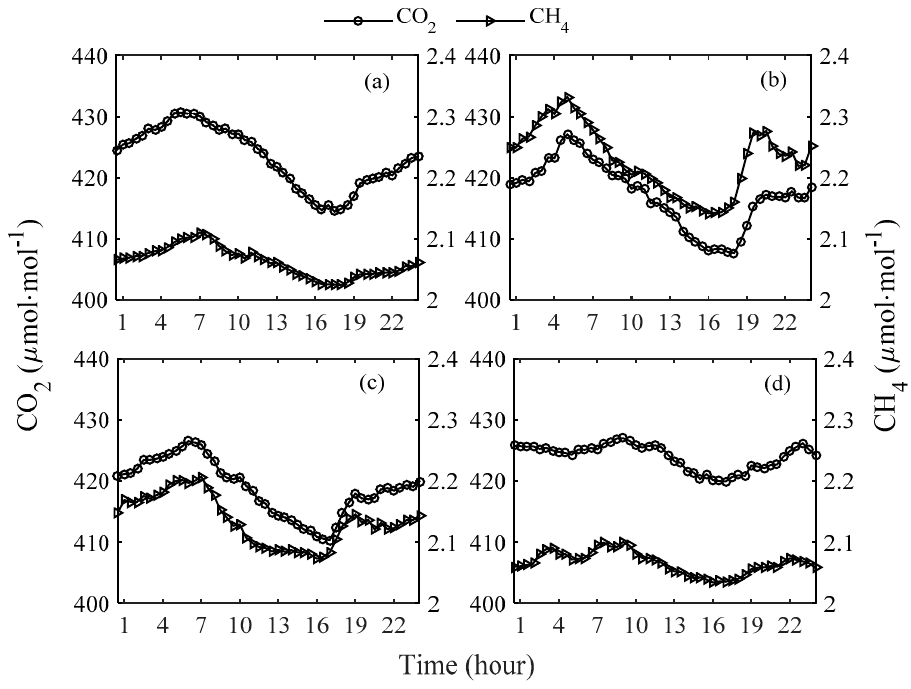
Figure 5. Diurnal variations of the molar fraction of CH 4 and CO 2 in the atmosphere in the four seasons in 2014: ( a ) spring; ( b ) summer; ( c ) autumn; and ( d ) winter.